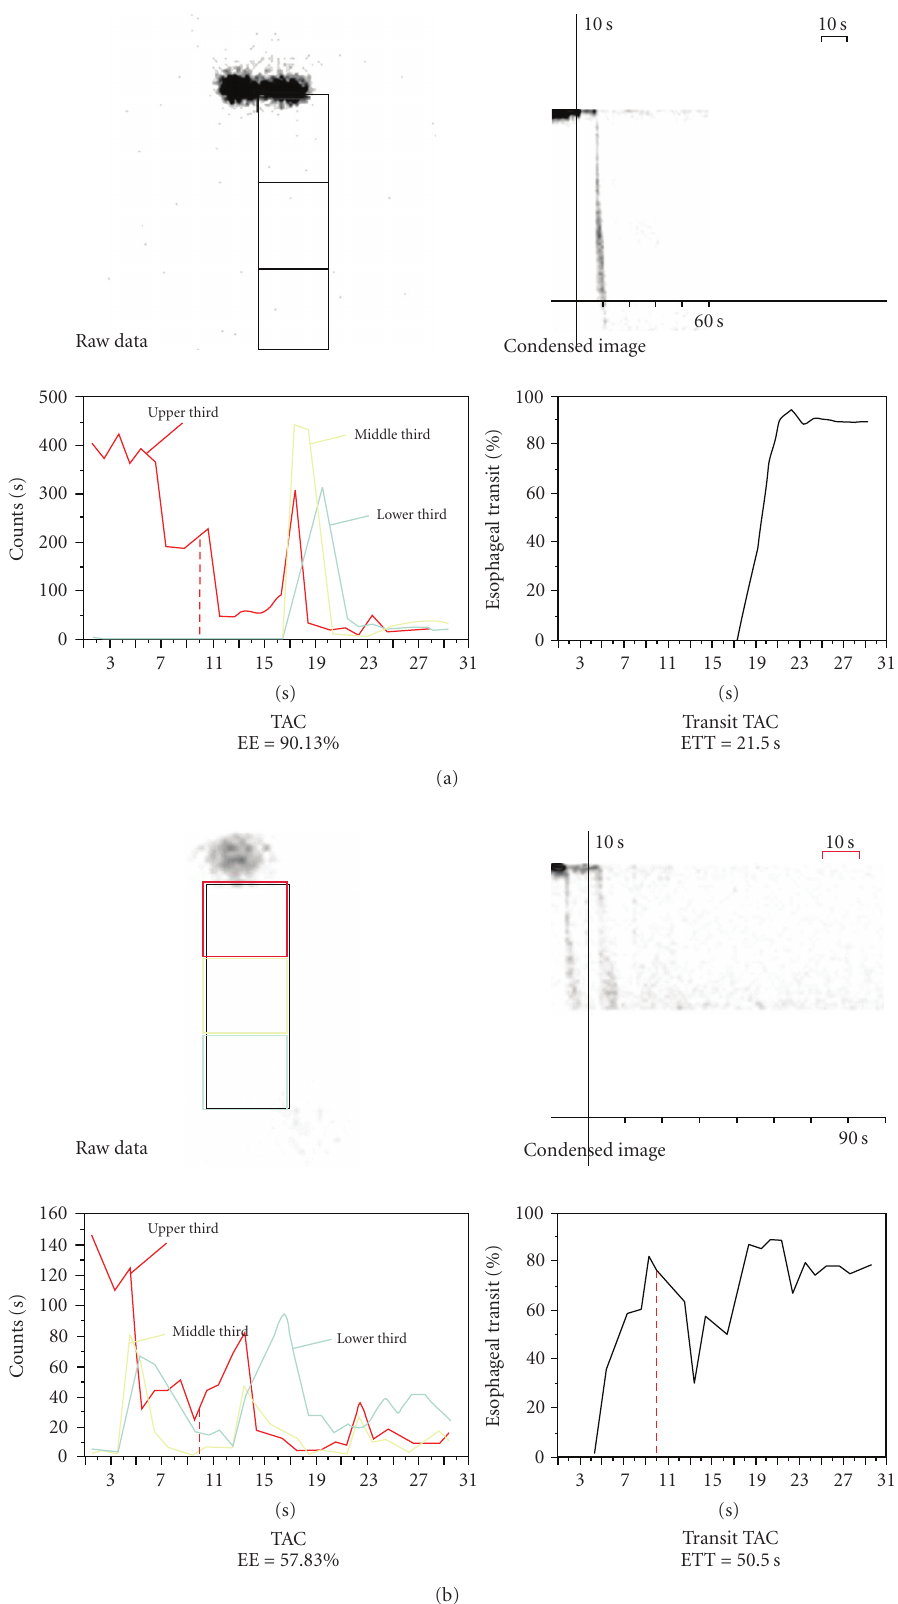
Figure 1: (a) The normal esophageal emptying (90.13%) and esophageal transit time (21.50 sec) in a healthy case of control group. (b) The delayed esophageal emptying (57.83%) and the extended esophageal transit time (50.50sec) in a hypothyroid